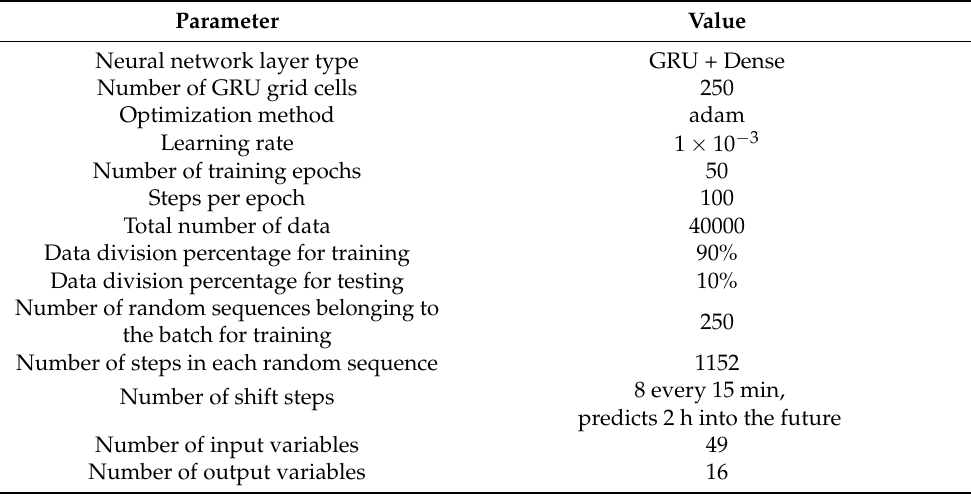
Table 3. Parameters setup in the GRU + Dense